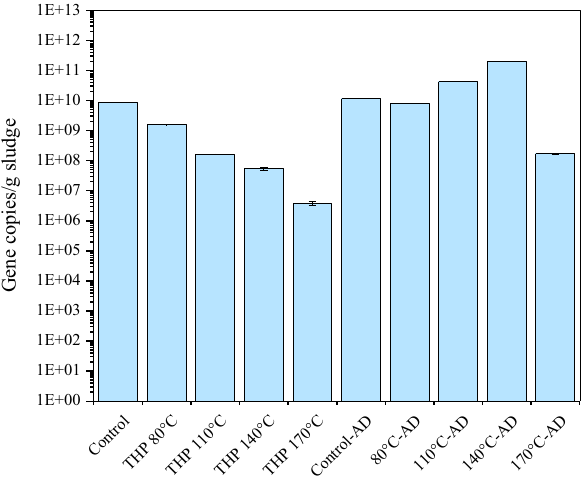
Figure 4. 16S rRNA gene copies in raw, pretreated, and digestate sludge